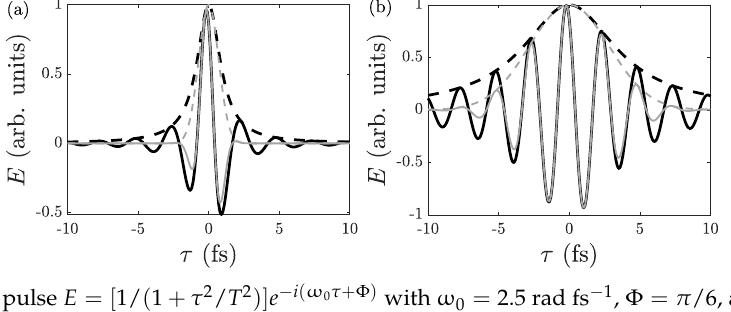
Figure 2. The pulse E = [ 1/ ( 1 + τ 2 / T 2 )] e − i ( ω 0 τ + Φ ) with ω 0 = 2.5 rad fs − 1 , Φ = π /6, and ( a ) T = 1 fs and ( b ) T = 4 fs (solid black curves), their amplitudes | E | (dashed black curves), and their approximations E c = e − τ 2 / ∆ t 2 c e − i ( ¯ ω c τ + Φ ) (gray solid curves) and | E c | (dashed gray curves) based on the central frequency ω c = 2.5 fs − 1 and the central width ∆ t c = T